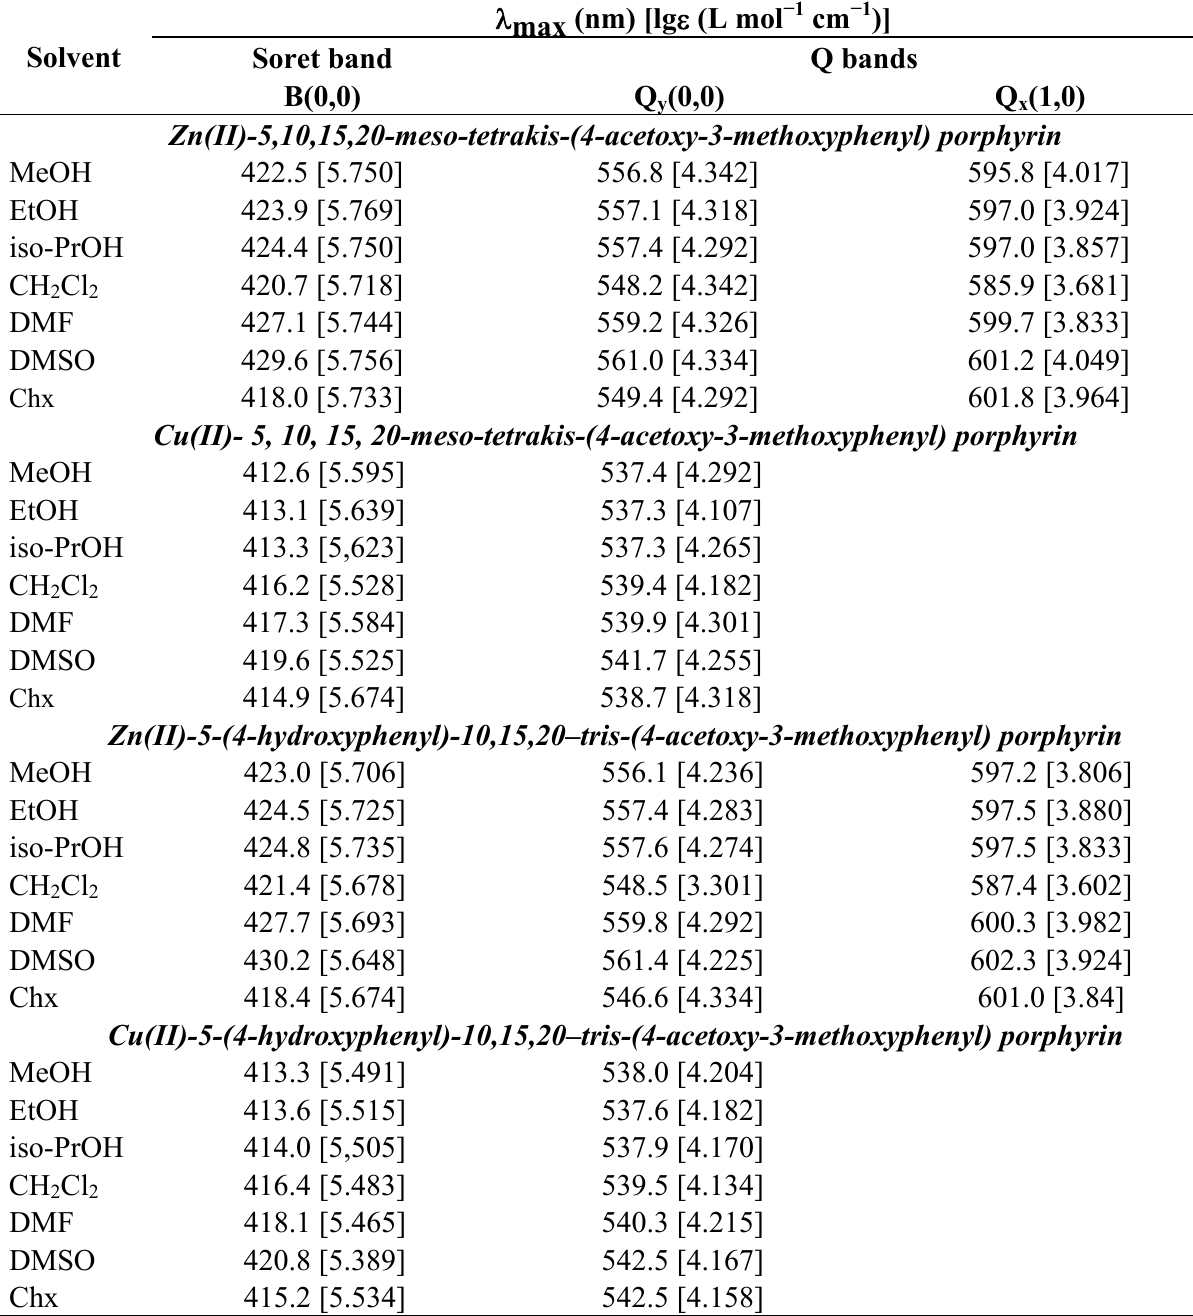
Table 2. Maximum wavelength and molar absorptivity of the mesoporphyrinic complexes in different solvents (c = 2.5 × 10 − 6